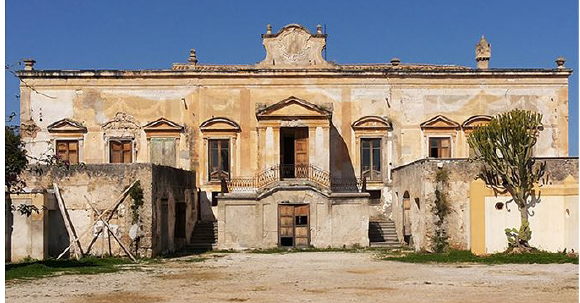
Figure 2. Main façade of Villa Lampedusa ai